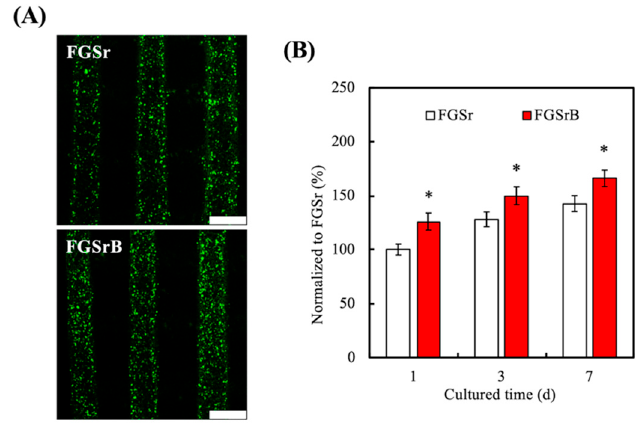
Figure 6. ( A ) The image of live/dead assay results of Wharton jelly-derived mesenchymal stem cells (WJMSC)-laden FGSr and FGSrB scaffolds for 1 day. Scale bar: 400 µm. ( B ) Cell viability of WJMSC-laden FGSr and FGSrB sca ff olds for di ff erent time points Data presented as mean ± SEM, n = 6 for each group. “*” indicates a significant di ff erence ( p < 0.05) when compared to